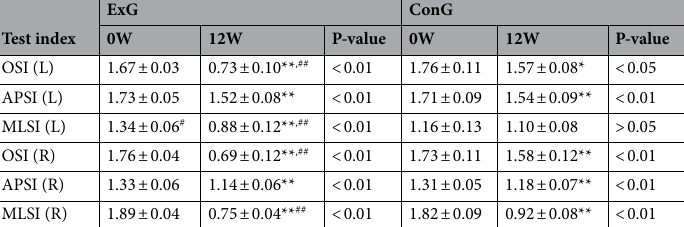
Table 5. Comparative analysis of subjects’ single leg stability test (SLST) results. Within-group differences *P < 0.05, **P < 0.01; Differences between groups # P < 0.05, ## P <